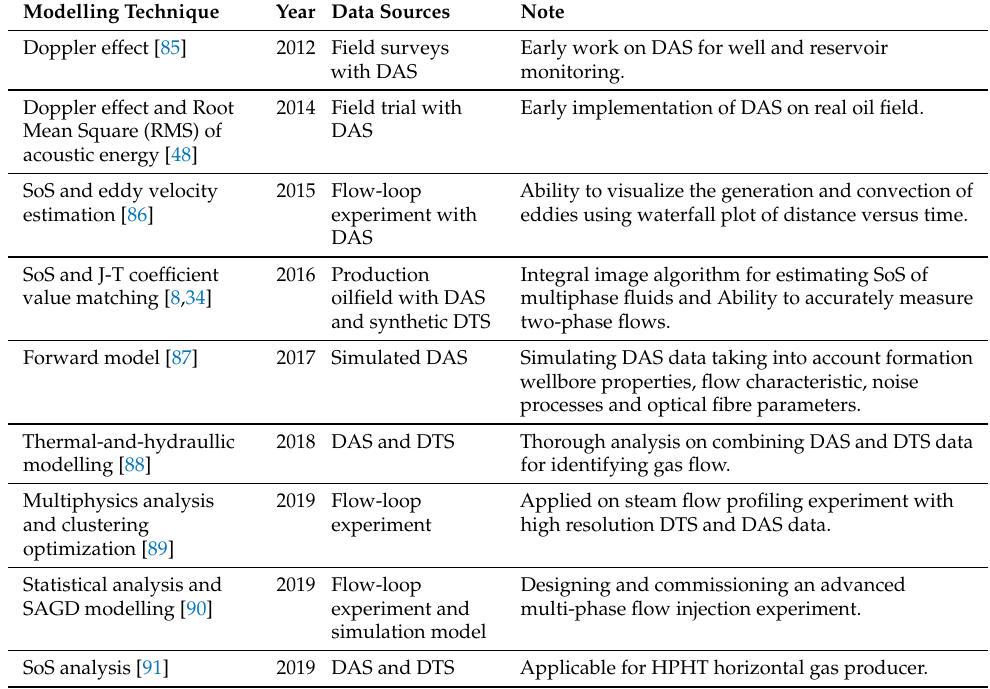
Table 1. Comparison of physical flow modelling techniques used with distributed fibre optic sensors for flow rate estimation and multiphase